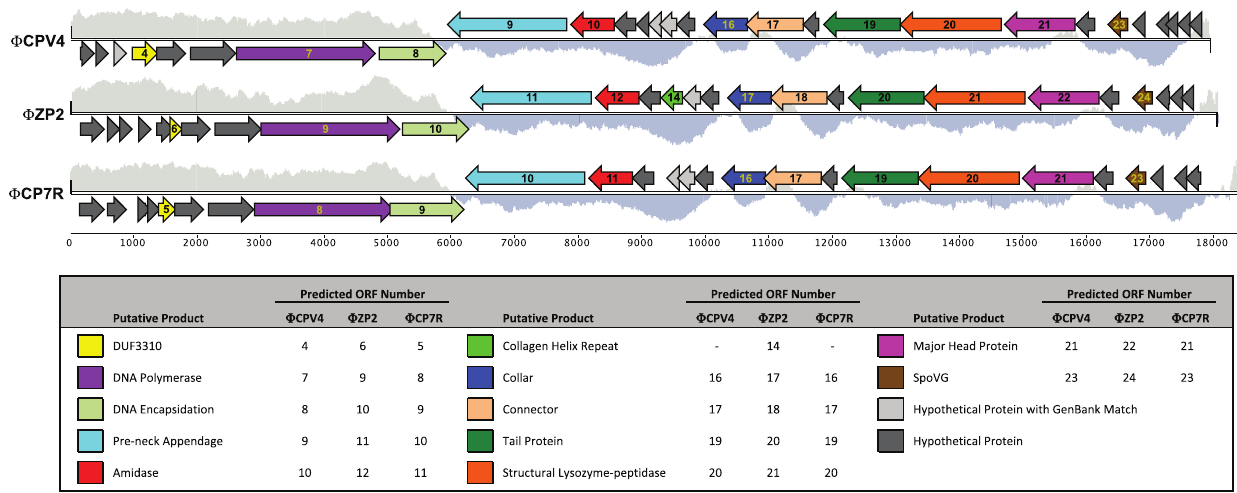
Figure 2. Comparative Genome Maps for Podoviral Bacteriophages Isolated from the Russian Federation and the USA. The %GC plot displays regions (500-bp window) above and below the average GC content. Open reading frames (ORFs) are depicted as arrows in the predicted direction of transcription and identified putative protein domains are listed in the legend with their respective ORF designation.